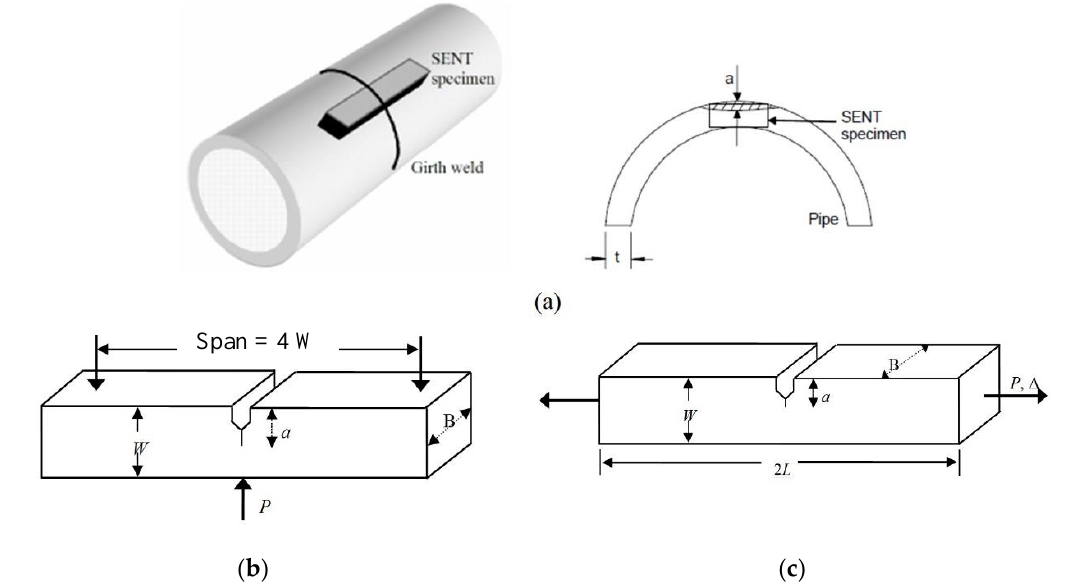
Figure 3. Specimen configurations. ( a ) Schematic plot of the relationship between single-edge-notched tension (SENT) and pipe; ( b ) single-edge-notched bending (SENB) with a/W = 0.5; ( c ) SENT with a/W = 0.3.